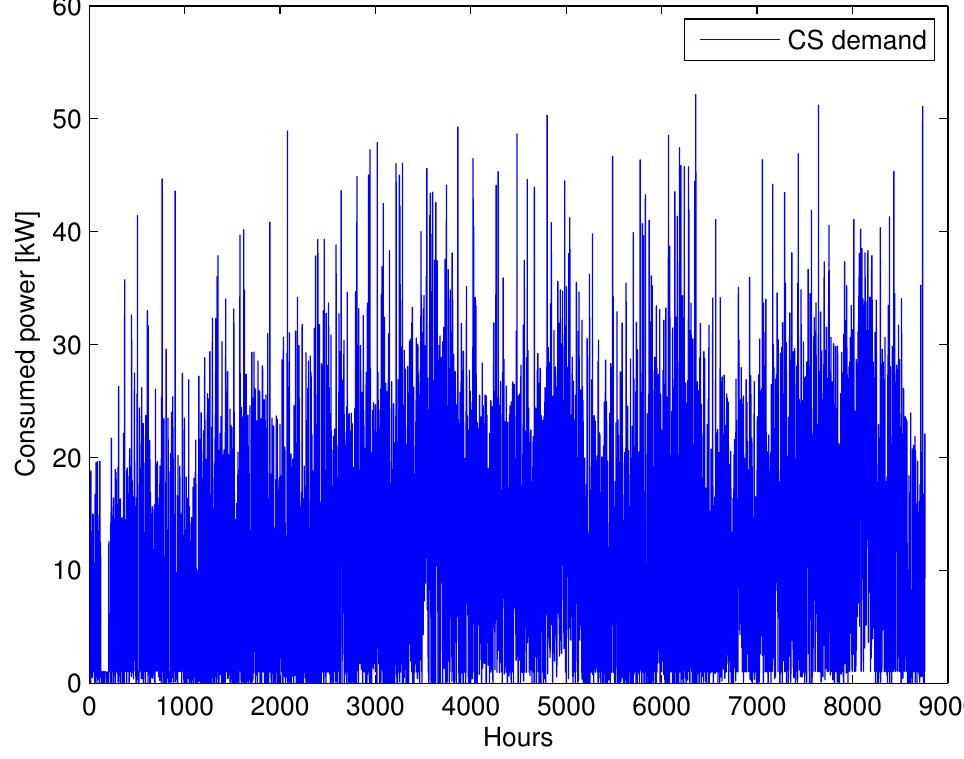
Figure 13. Charging spot demand for 2017 at a charging station in